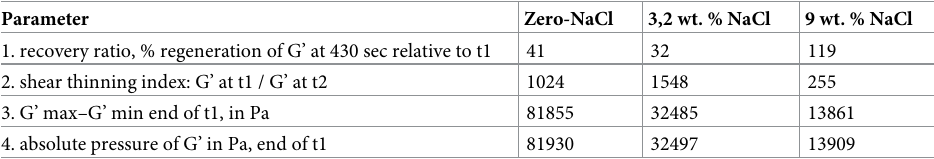
Table 1. Semi-quantitative parameters derived from the rheological